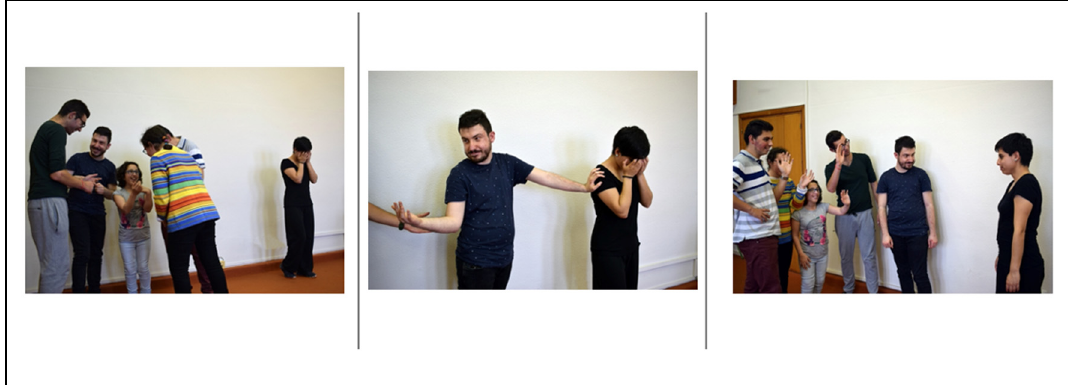
Figure 2. Sequence on the importance of social relationships.